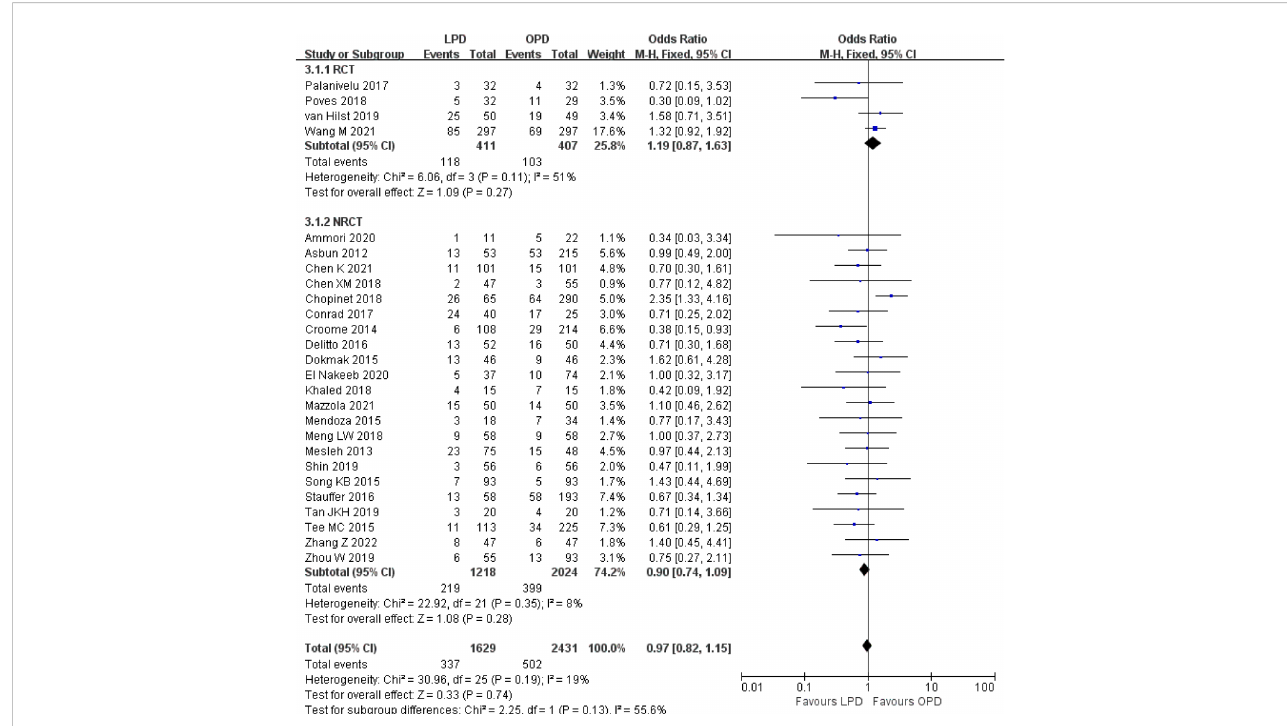
FIGURE 3 Forest plot of comparison between LPD and OPD on serious postoperative complications. LPD, laparoscopic pancreaticoduodenectom; OPD, open pancreaticoduodenectomy.